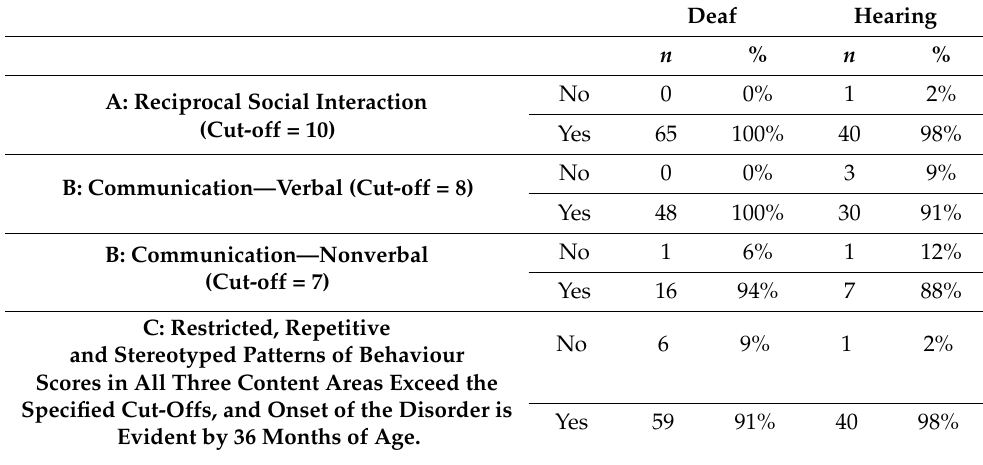
Table 3. Classification based on the cut-off scores as published by Rutter et al. 2003.